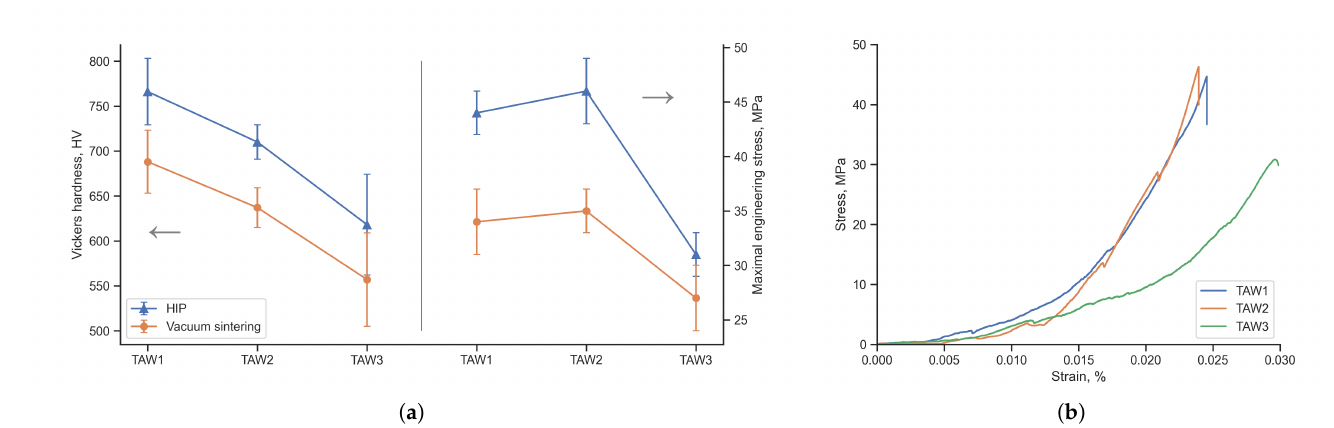
Figure 5. Vickers microhardness and maximal engineering stress ( a ) of the samples after vacuum sintering and hot isostatic pressing (HIP), and stress–strain curve of the HIP samples ( b